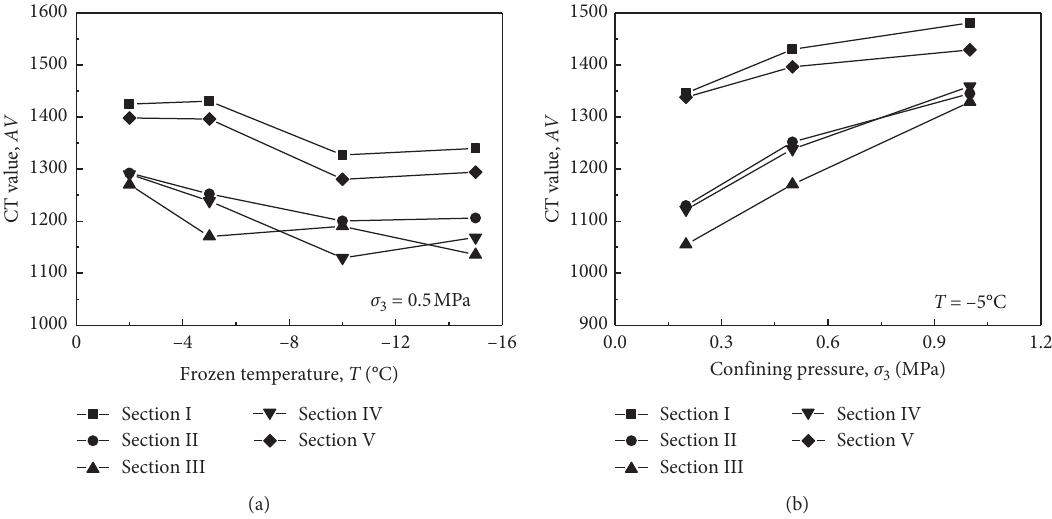
Figure 10: CT value under (a) different frozen temperatures and (b) confining pressures.